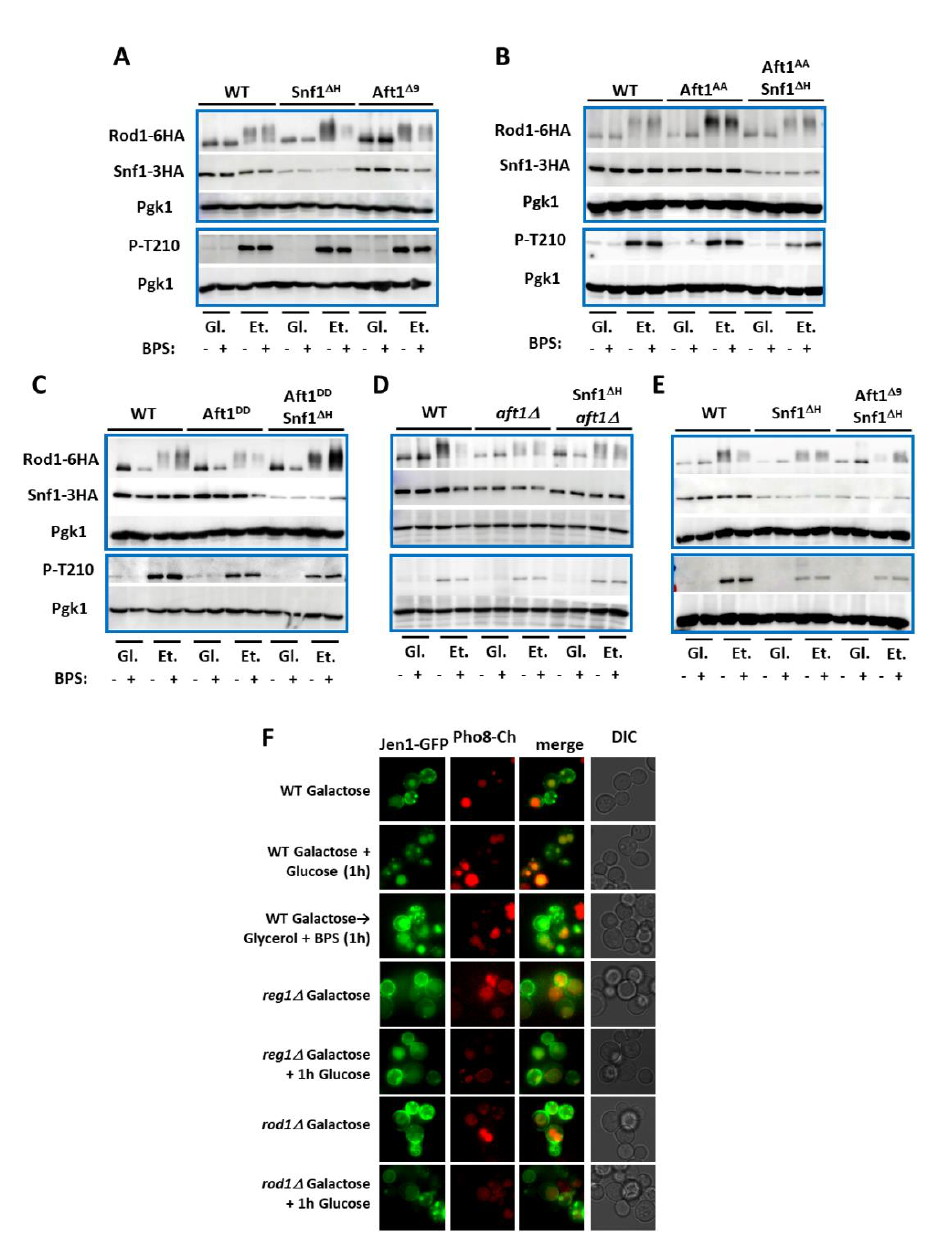
Figure 6. Non-nuclear substrates of Snf1 are not regulated by iron deprivation. ( A – E ) Western blots showing phosphorylation of Rod1-6HA, Snf1-3HA protein levels, and phosphorylation of Snf1 at T210 following transfer of indicated cells from glucose (Gl) media to ethanol (Et) media (and adding 0.1 mM BPS as indicated) for 30 min. ( F ) Internalization of Jen1-GFP. Jen1-GFP was expressed from a GAL promoter overnight. Either glucose at 2% was added to internalize Jen1-GFP (vacuoles are marked with Pho8-Cherry) or the galactose was washed out and replaced by glycerol + 100 μM BPS to determine if iron deprivation leads to Jen1-GFP internalization.